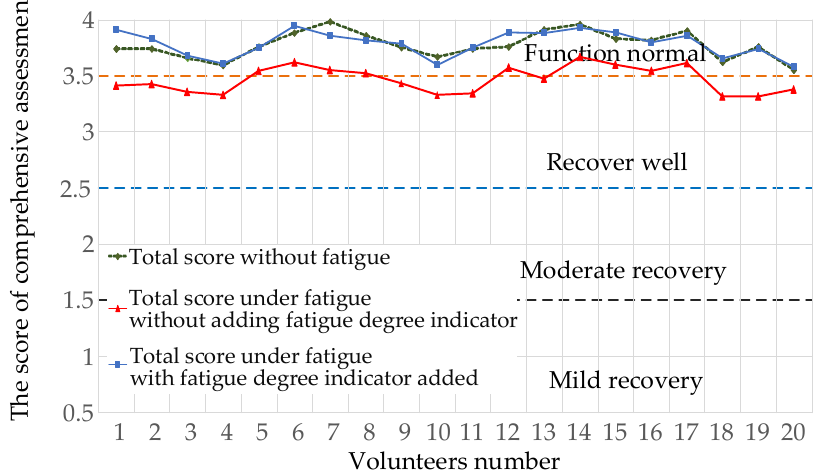
Figure 21. Comparison of comprehensive rehabilitation assessment.